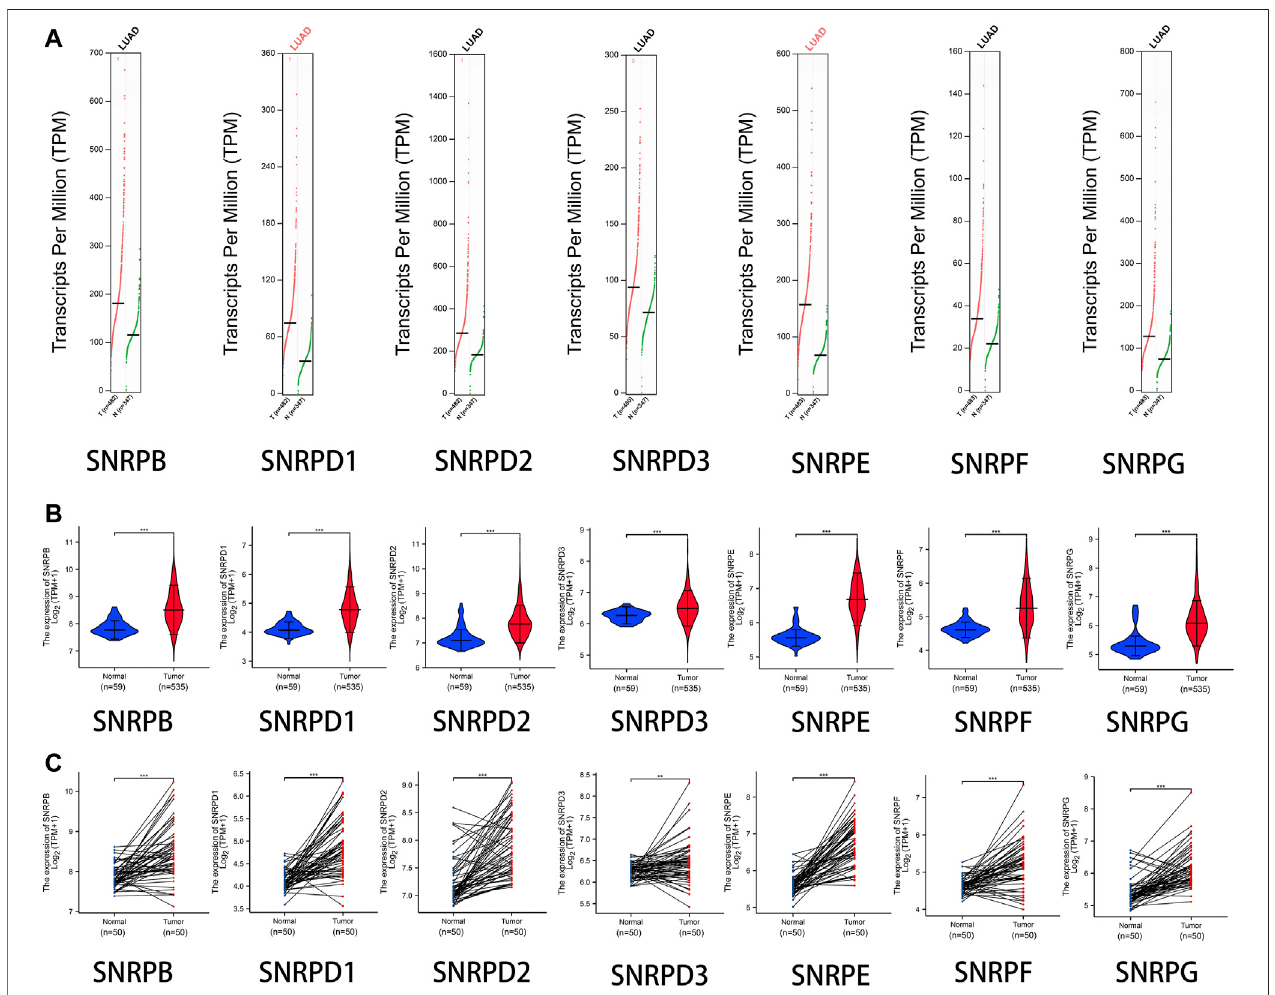
FIGURE 3 | The transcription levels of genes for Sm proteins in LUAD samples and normal lung samples. (A) The transcription levels of genes for Sm proteins in data of GEPIA 2 (TCGA-LUAD & GTEx). (B) Violin charts of mRNA level for Sm proteins in data of TCGA-LUAD. (C) The mRNA expressions of genes for Sm proteins in pair data of TCGA-LUAD. Students T-test was performed to assess the statistical signi fi cance. A p value of < 0.05 was regarded as statistically signi fi cant.